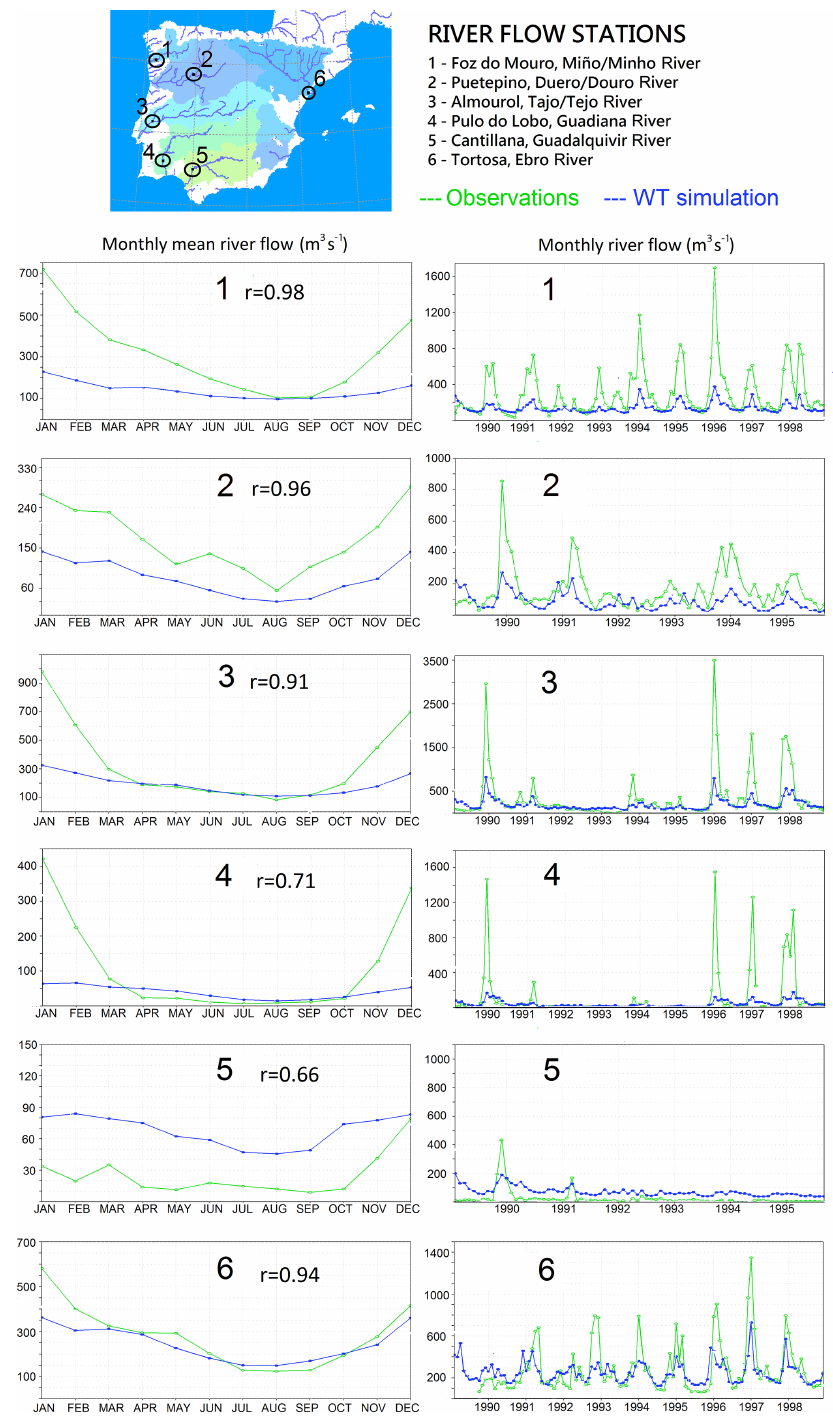
Figure 6. Top panels: river flow gauge stations at the six largest Iberian rivers selected for validation: Foz do Mouro station close to the Miño/Minho river mouth (station 1, drainage area of 15407km 2 ), Puentepino station in the Duero/Douro River basin (station 2, drainage area of 63160km 2 ), Almourol station in the Tajo/Tejo basin (station 3, drainage area of 67482km 2 ), Pulo do Lobo station in the Guadiana basin (station 4, drainage area of 61885km 2 ), Cantillana station in the Guadalquivir basin (station 5, drainage area of 44871km 2 ), and Tortosa station by the Ebro River mouth (station 6, drainage area of 84230km 2 ). Graphs on the left: mean monthly river flow (m 3 s − 1 ) and correlation index between observed and simulated time series (we use the mean seasonal cycle for the index). Graphs on the right: monthly river flow (m 3 s − 1 ) time series. Blue for the WT simulation, green for observations. The Puentepino and Cantillana stations’ data availability ends in